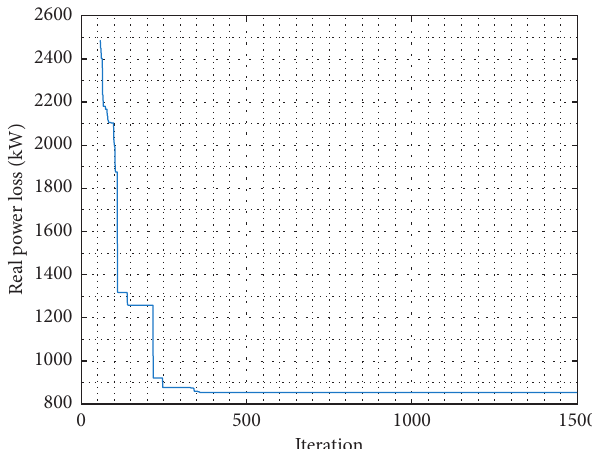
Figure 10: Convergence characteristic of the power loss for the 119-bus system.